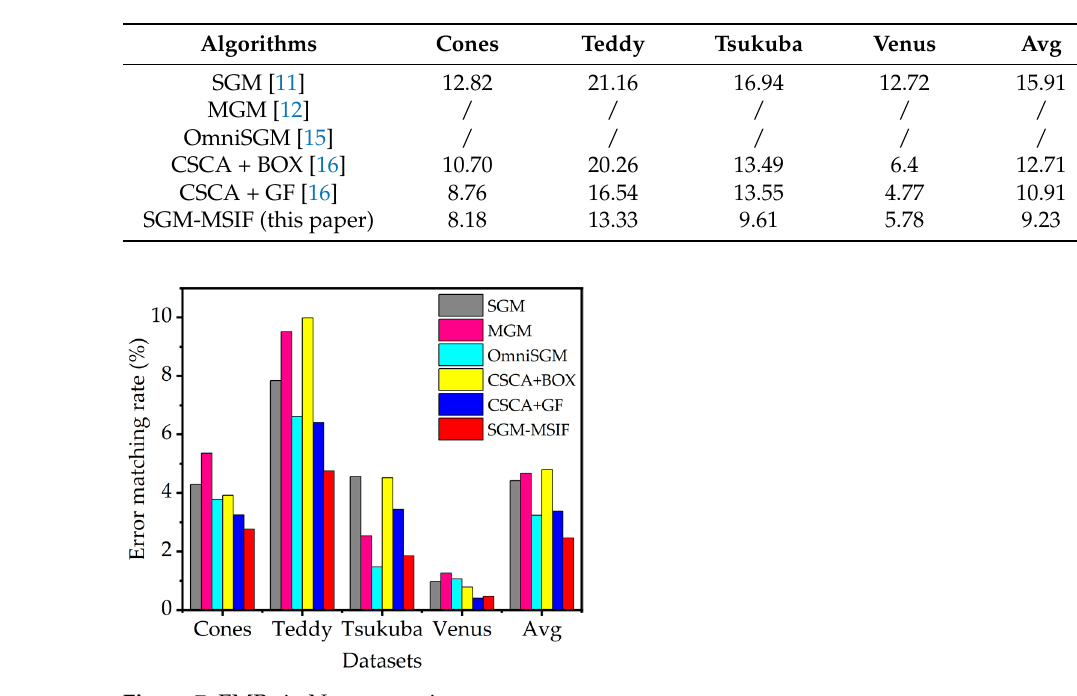
Table 4. Comparison of EMRs in Disc regions of six algorithms (%). “/”: the results are not available in the references.